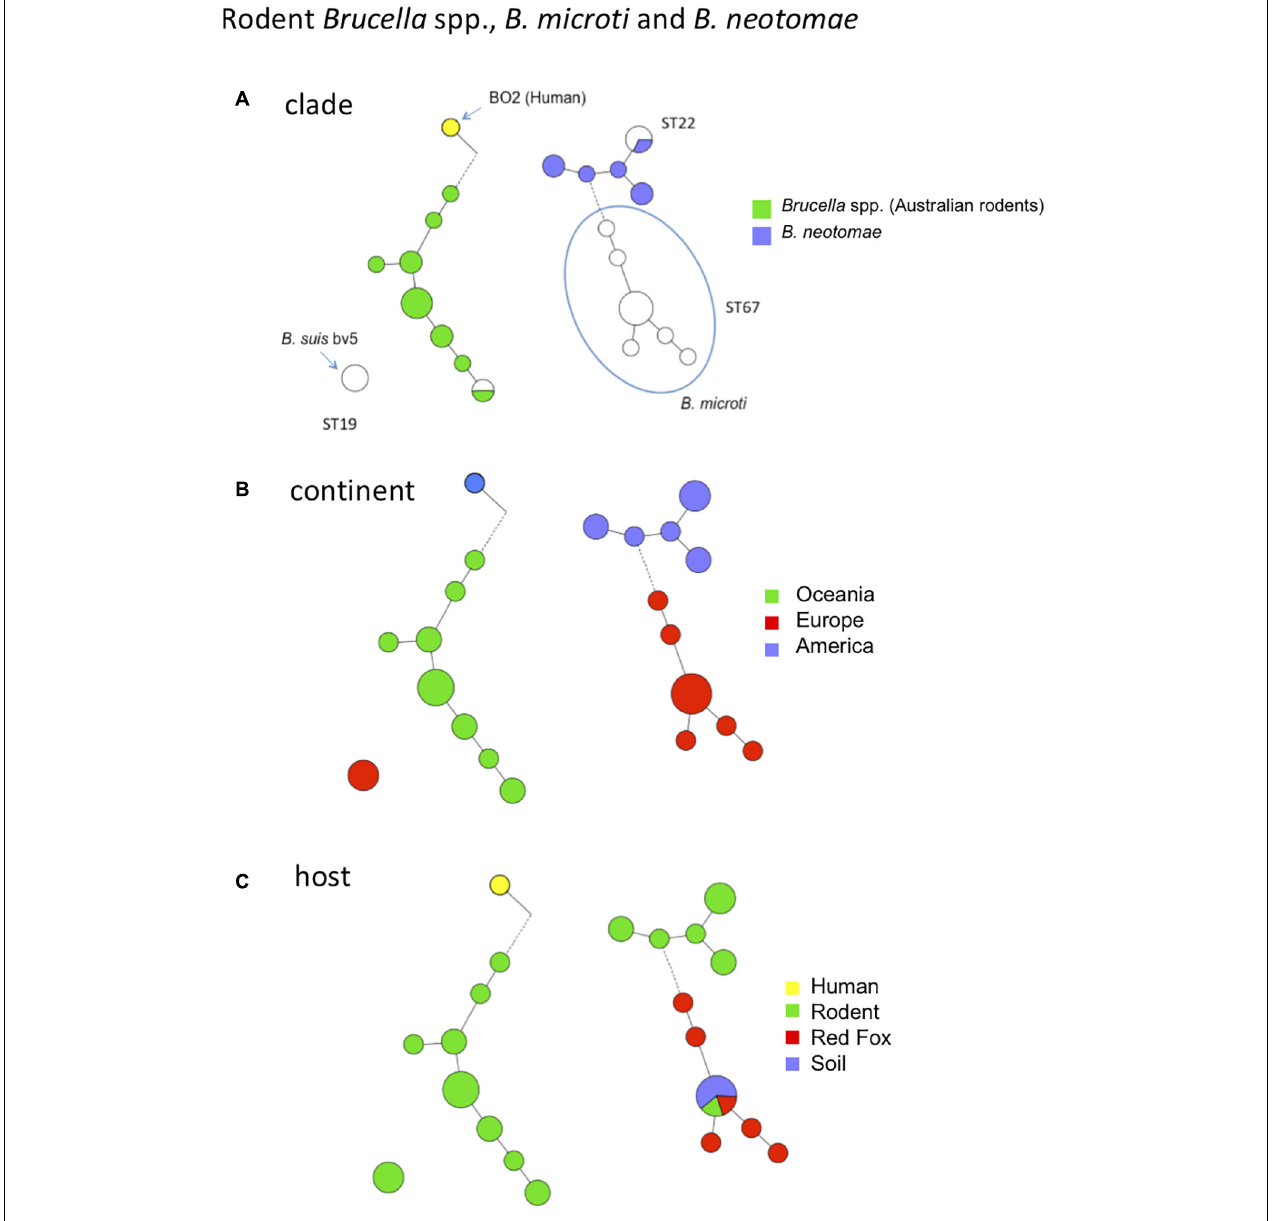
FIGURE 5 | MLVA11 diversity of rodent Brucella spp., B. microti , B. neotomae and human Brucella sp. isolate BO2. Thirty-seven entries are used including 21 strains from this study ( B. neotomae , Brucella spp. from Australian rodents, and human Brucella sp. isolate BO2), six representative entries from in silico data and data from 10 previously reported strains including B. microti . (A) Color coding according to species and biovar. Uncolored (white) entries correspond to in silico or previously published data. The MLST21 ST genotype is indicated. (B) Color-coding according to geographic origin defined at continent level. (C) Color-coding according to